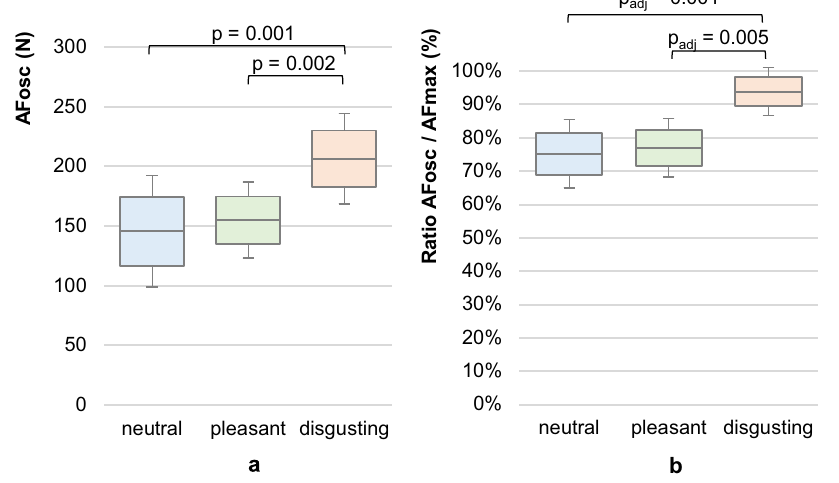
Figure 7. Adaptive Force at onset of oscillations. Displayed are the arithmetic means, standard deviations (error bars) and 95%-CIs of ( a ) the Adaptive Force at the moment of onset of oscillations (AFosc) and ( b ) the ratio of AFosc to AFmax comparing the different odours neutral (blue), pleasant (green) and disgusting (orange). The p-values of significant comparisons are